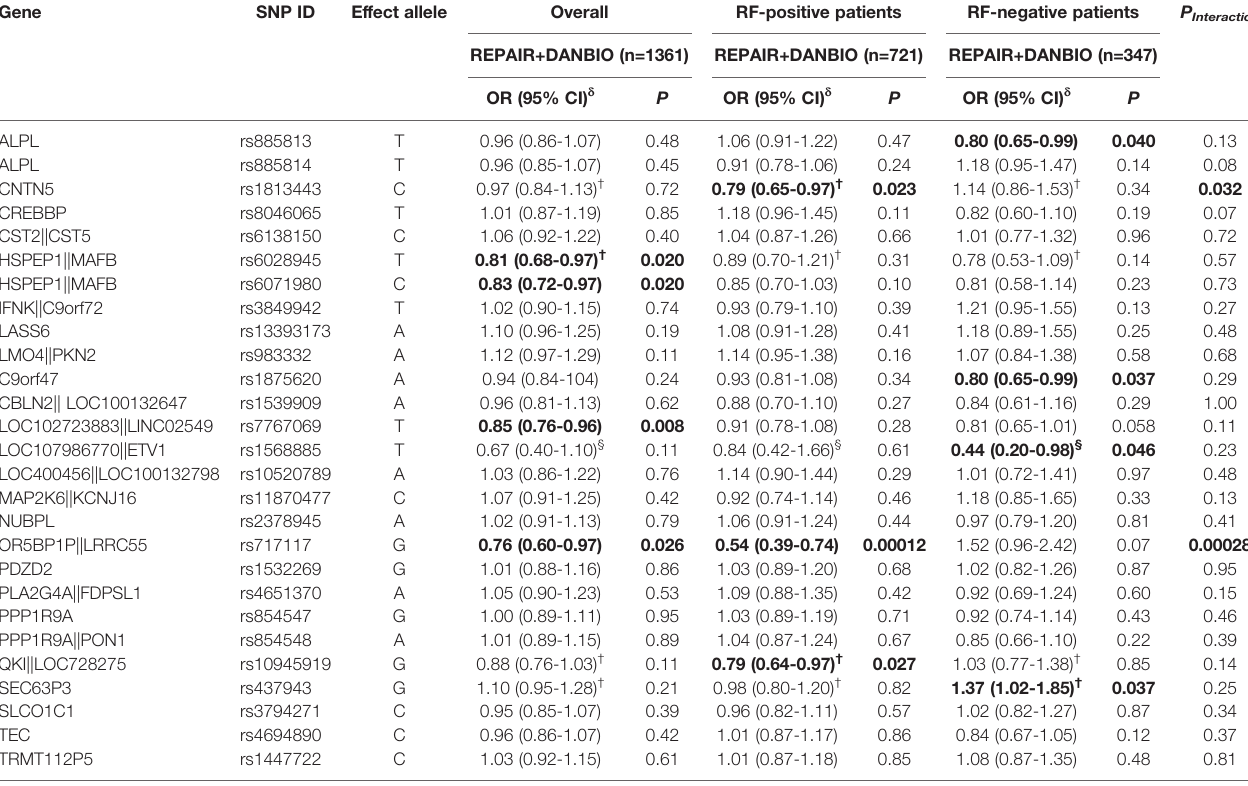
TABLE 3 | Overall and RF-speci fi c associations of selected polymorphisms and response to anti-TNF drugs ( D DAS28) in the REPAIR consortium. Gene SNP ID Effect allele Overall RF-positive patients RF-negative patients P Interaction REPAIR+DANBIO (n=1361)